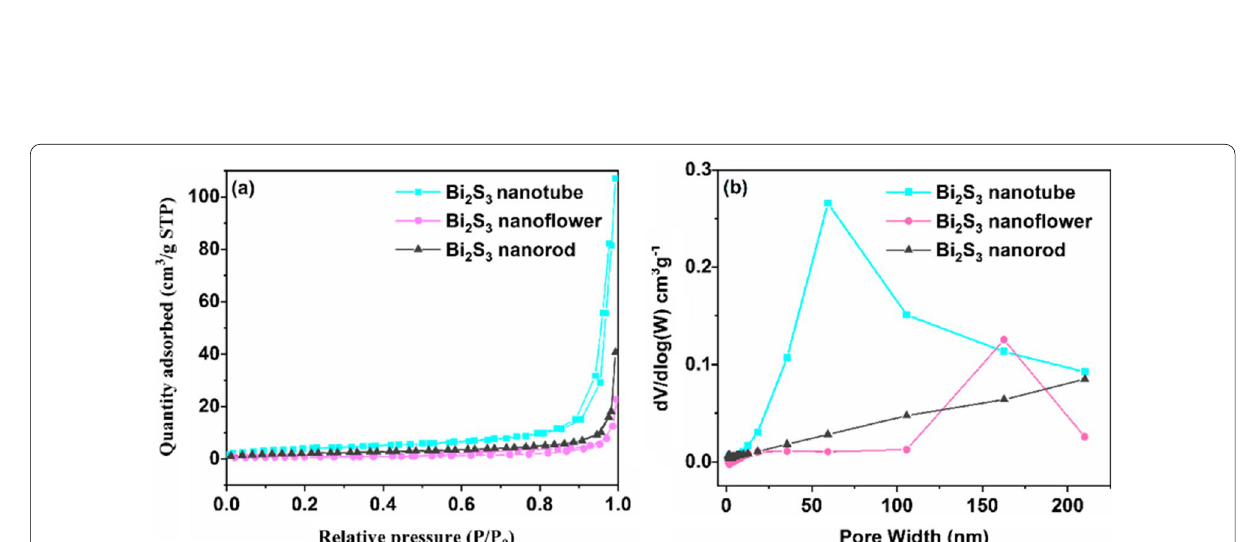
Fig. 4 a N 2 adsorption–desorption isotherms and b pore size distribution of the Bi 2 S 3 samples with different